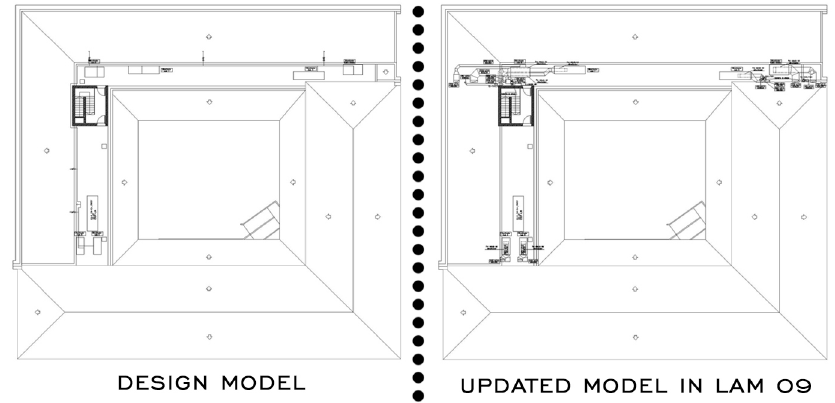
Figure 9. Through BIM it was possible to recreate the possible workspaces on roof 2D drawings with impossibility to visualize workspace